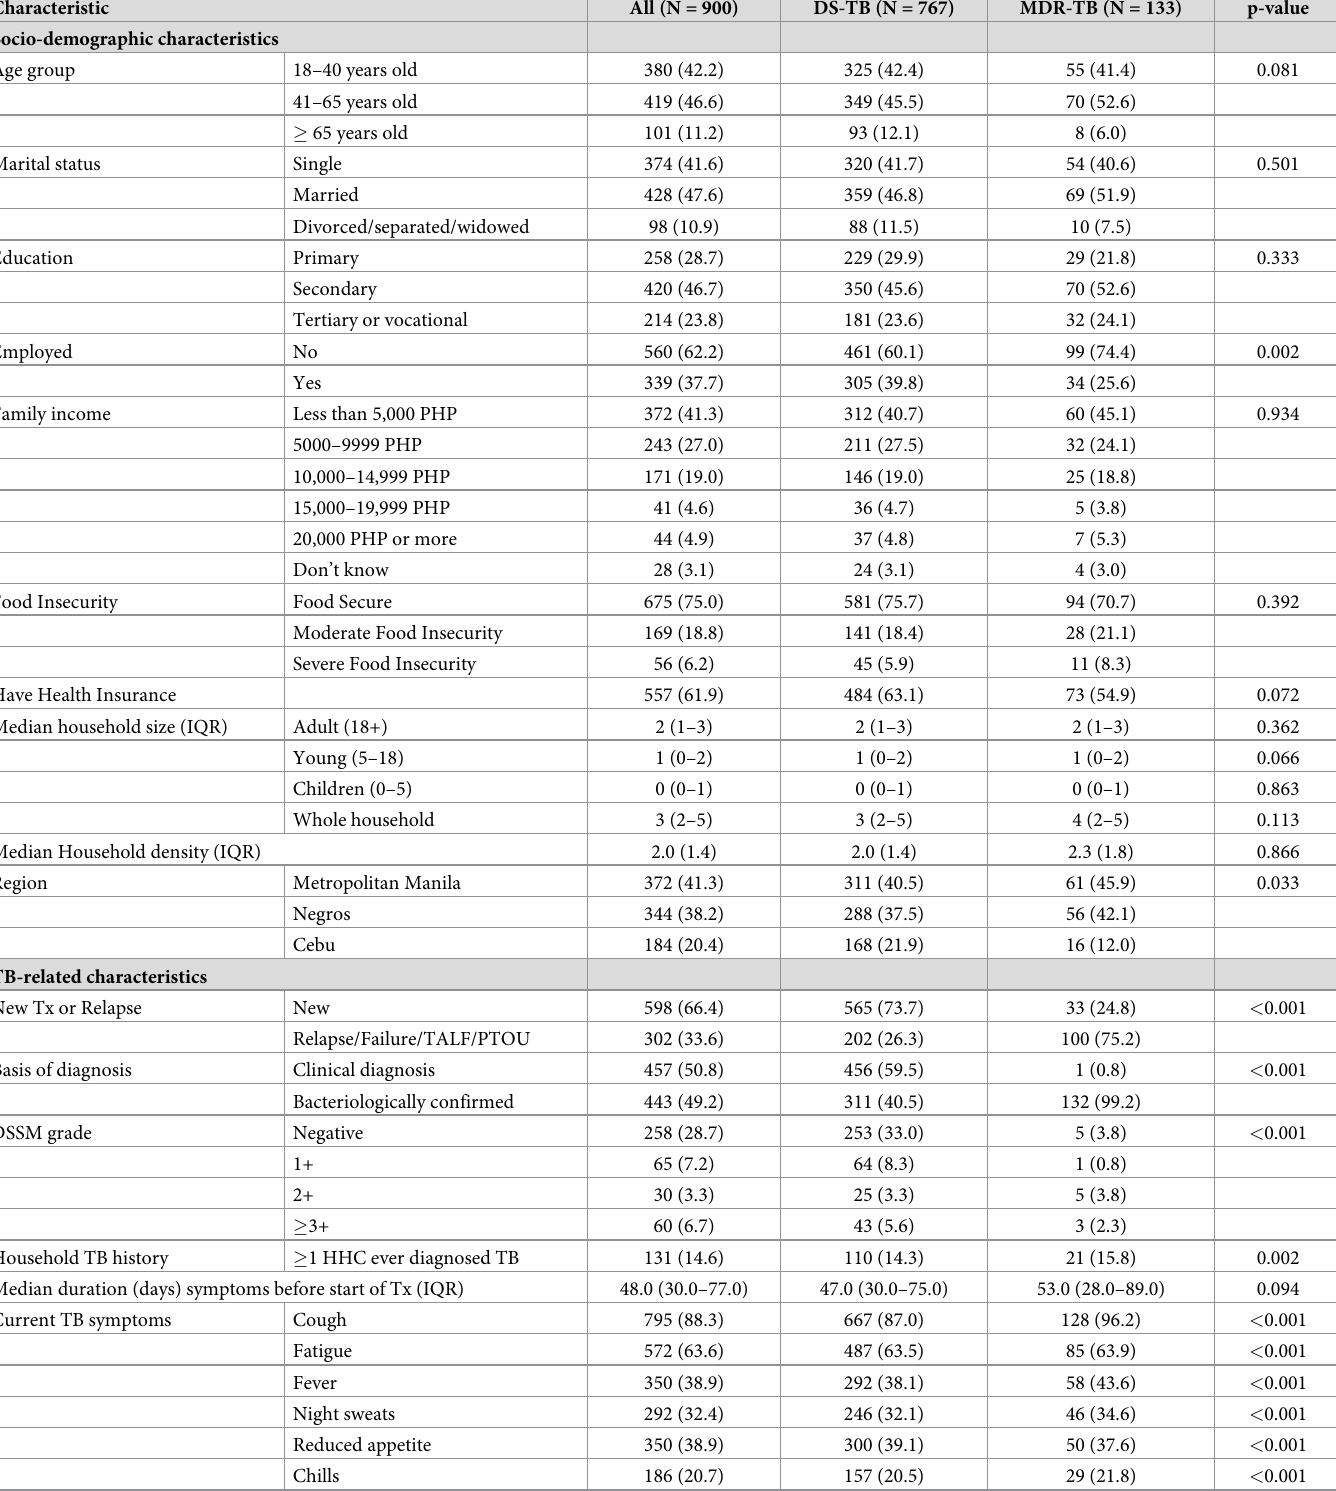
Table 1. Socio-demographic and TB-related characteristics of study participants at